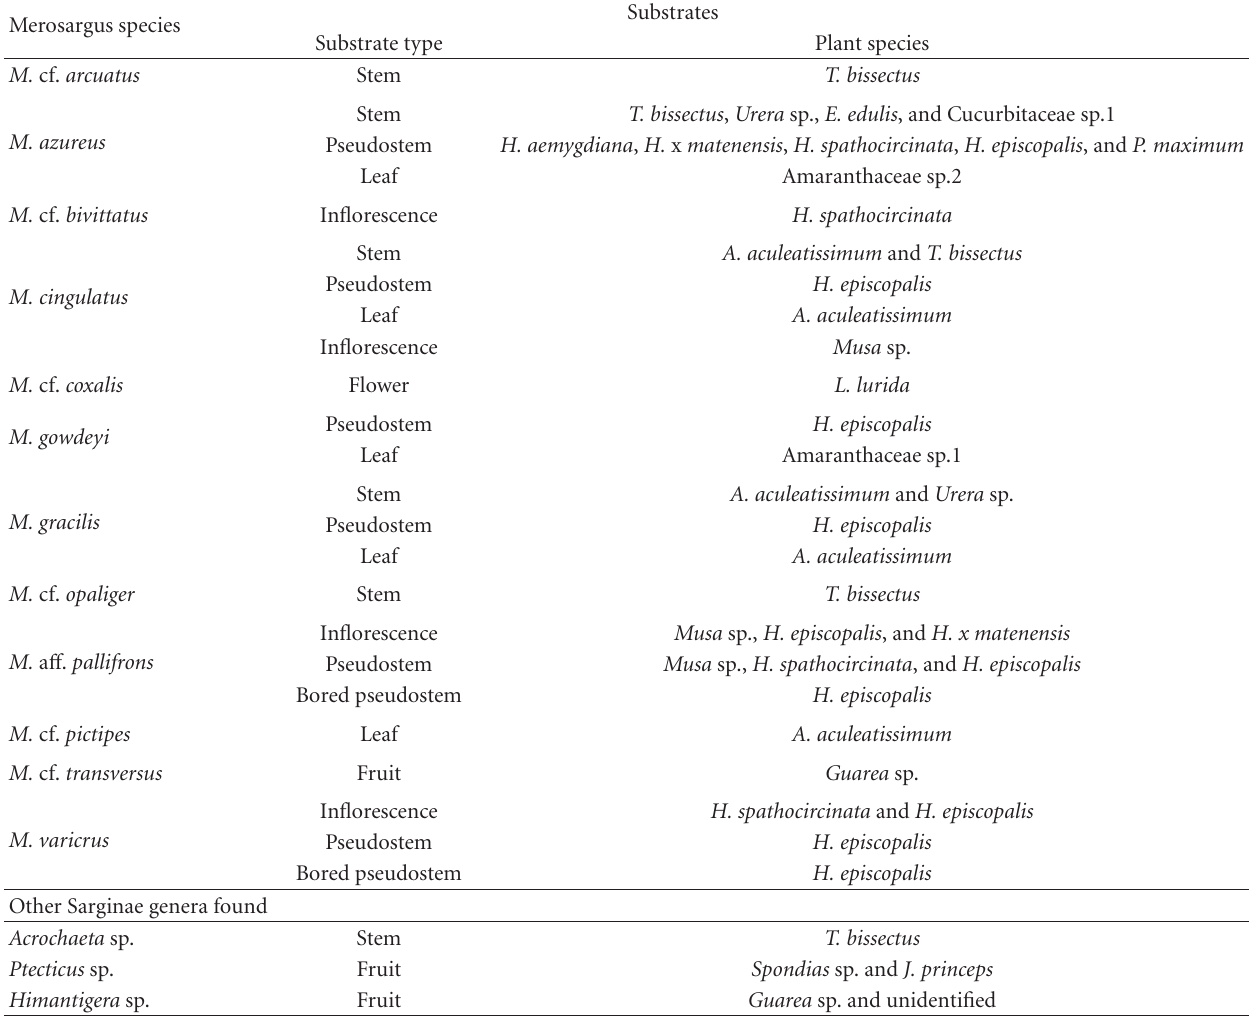
Table 2: Merosargus species with respective plant species and substrate types found in samples collected at the Parque Estadual do Rio Doce (PERD), Minas Gerais, Brazil, between October 2001 and October